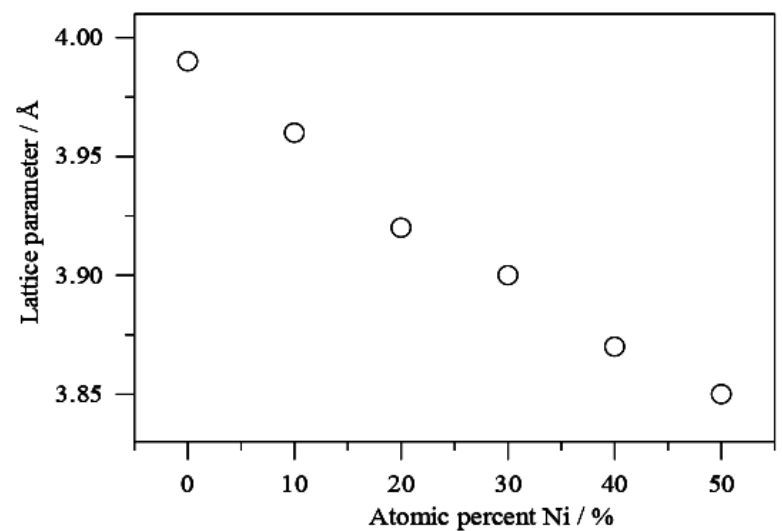
Figure 2. Variation of the lattice parameters vs percentage of Ni in PdNi/C alloys.